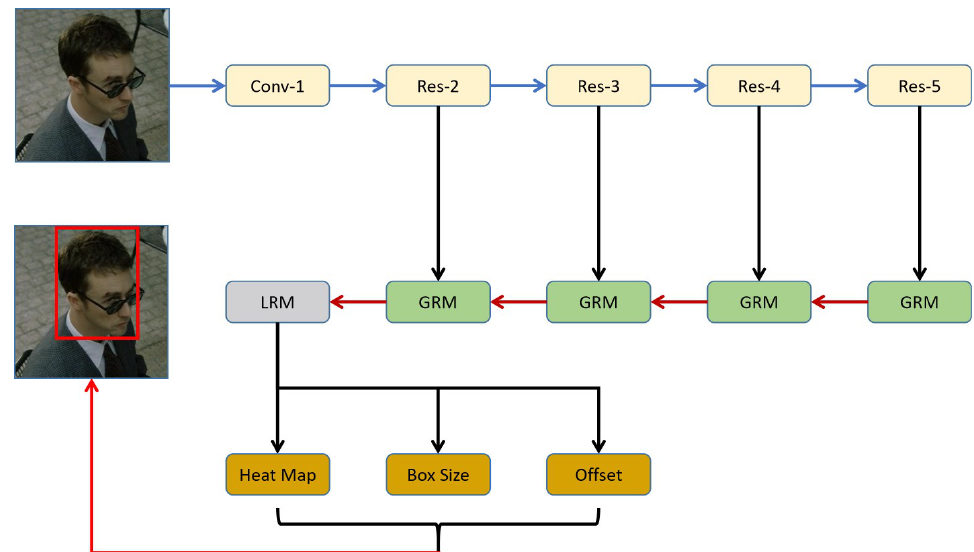
Figure 1. An overview of our CRN architecture: the yellow part is the